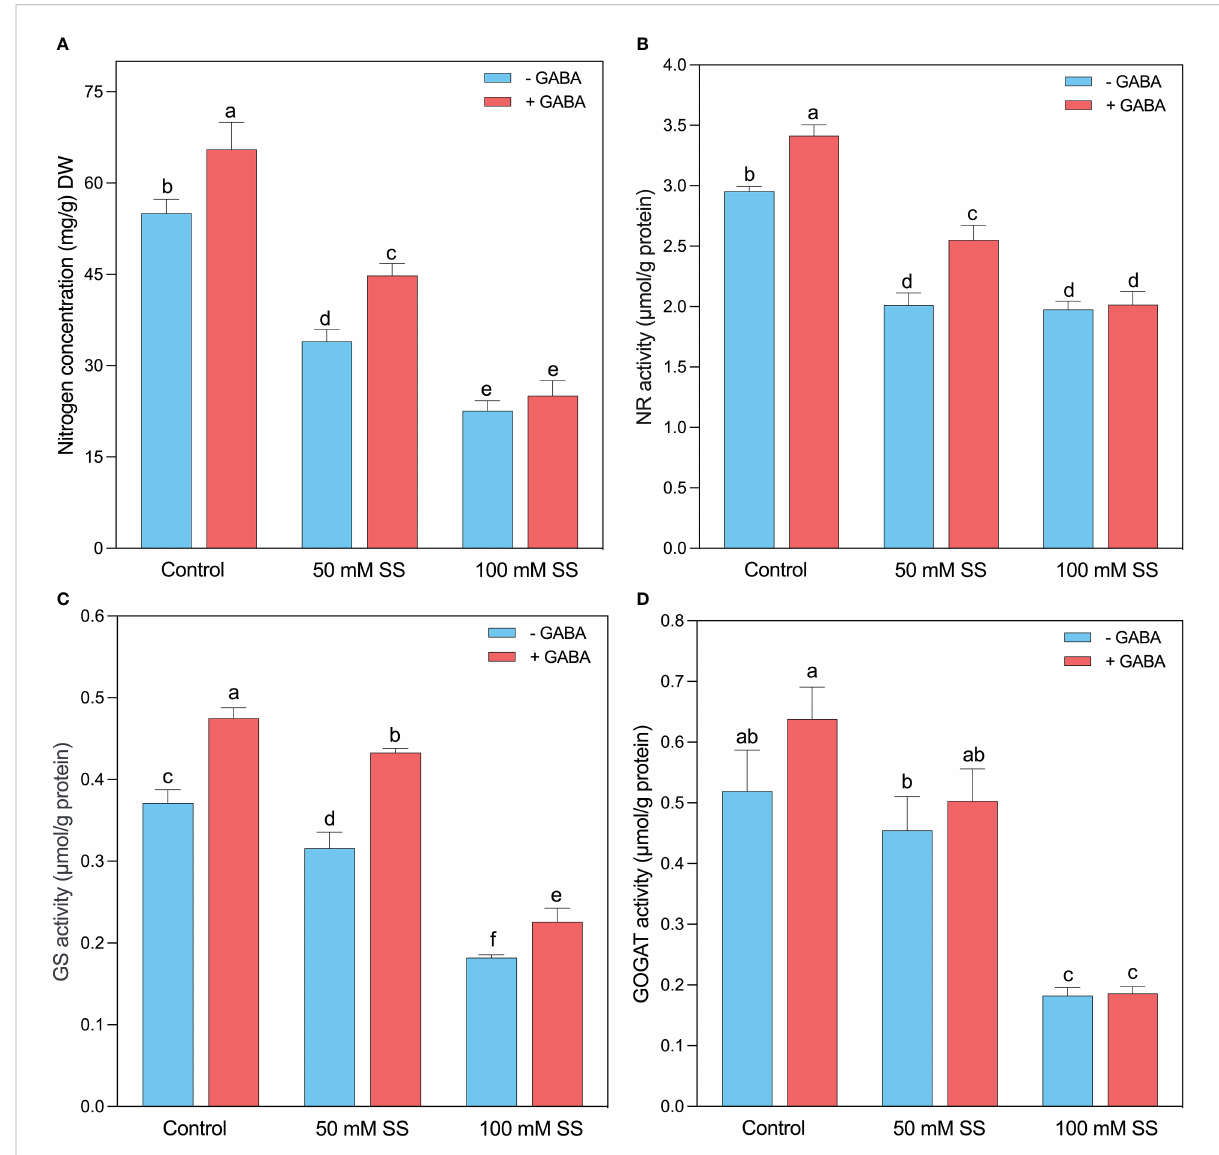
FIGURE 6 Changes in concentrations of (A) N concentration and enzymatic activities of (B) NR, (C) GS, and (D) GOGAT of mungbean plants under saline stress (SS) and exogenous ( g -aminobutyric acid) treatments. The bars indicate the SE of the mean value, n=3. Different letters above the bars indicate signi fi cantly different values at P <0.05 following Duncan ’ s